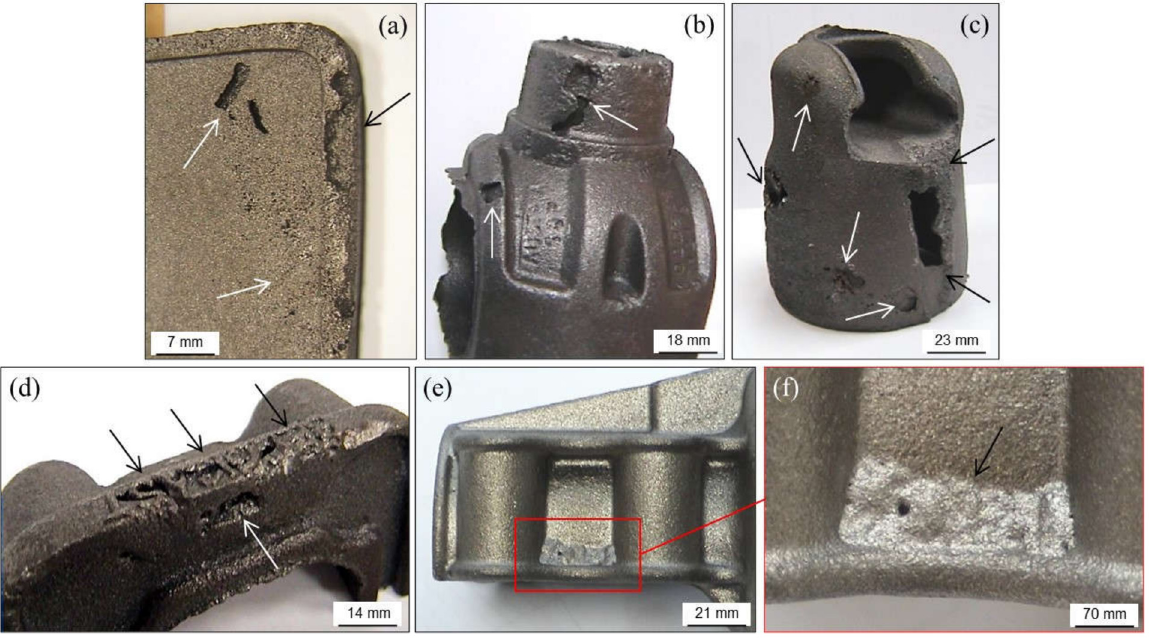
Figure 37. Sand cuts and washes in different locations of ductile iron castings ( a , b , d – f ). Severe sand wash in a malleable iron casting ( c